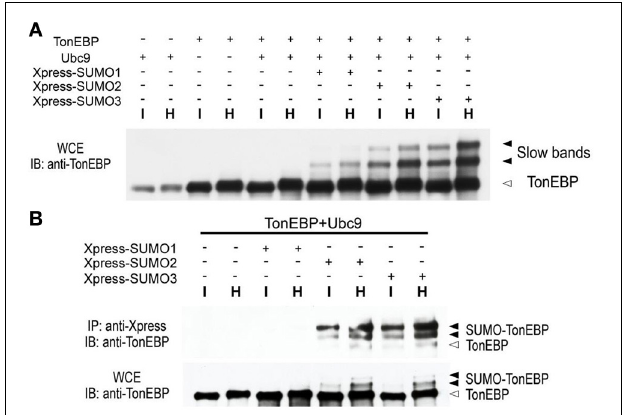
FIGURE 2 | TonEBP is sumoylated in response to hypertonicity. (A) HEK293 cells were transfected with various combinations of TonEBP, Ubc9, and Xpress-tagged SUMO1, SUMO2, or SUMO3, as indicated. After 20h, the cells were cultured for an additional 4h in isotonic (I) or hypertonic medium (H). Whole cell extracts (WCE) were prepared and immunoblotted (IB) for TonEBP. Positions of TonEBP and slow TonEBP bands are indicated. (B) Cells were transfected as above and WCE were immunoprecipitated using anti-Xpression antibody. Immunoprecipitates (top) and WCE (bottom) were immunoblotted for TonEBP. Positions of TonEBP and sumoylated TonEBP (SUMO-TonEBP) bands are indicated at right.